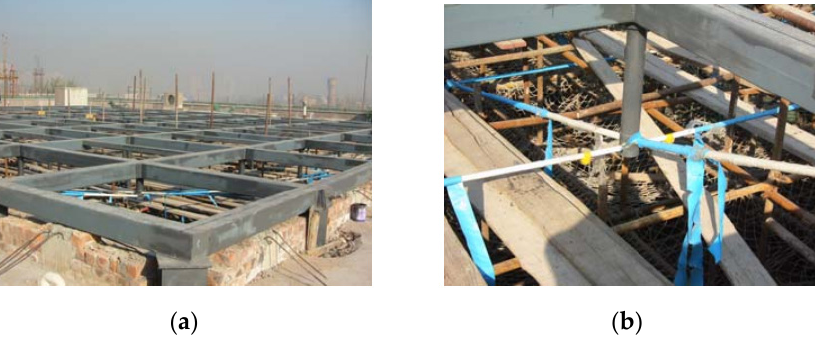
Figure 17. ( a ) Bidirectional string structure used in the experiment. ( b ) Frequency test of the bidi-